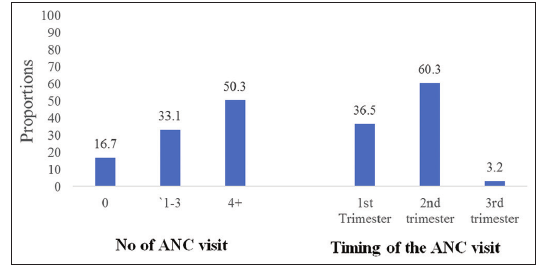
Figure 1: ANC attendance among women aged 15-24 years in